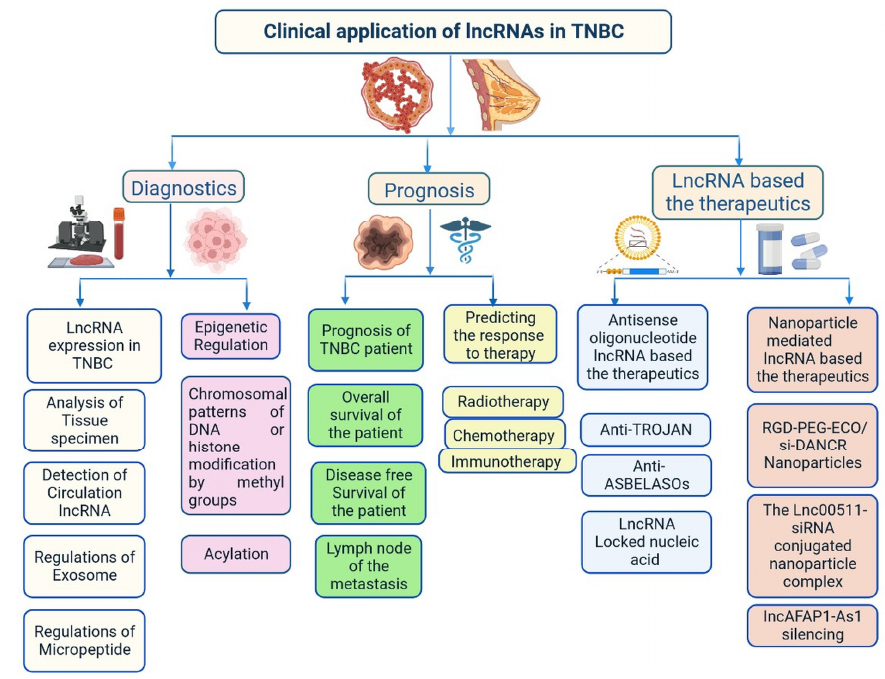
Figure 6. Clinical importance of lncRNA in triple-negative breast cancer. Table 1. Important lncRNAs associated with triple-negative breast cancer.